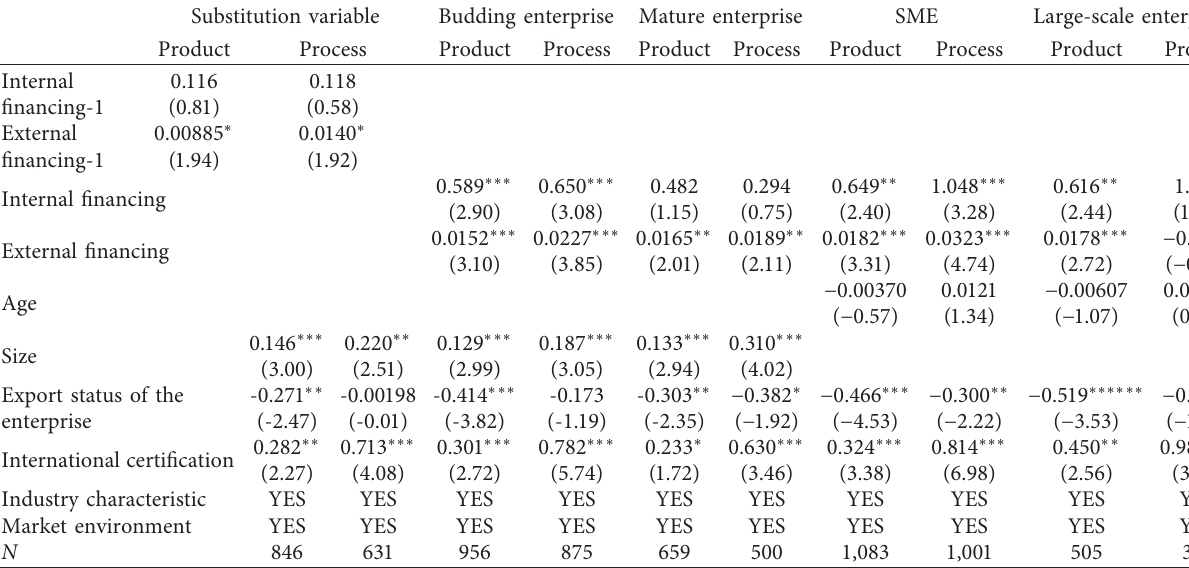
Table 9: Stability